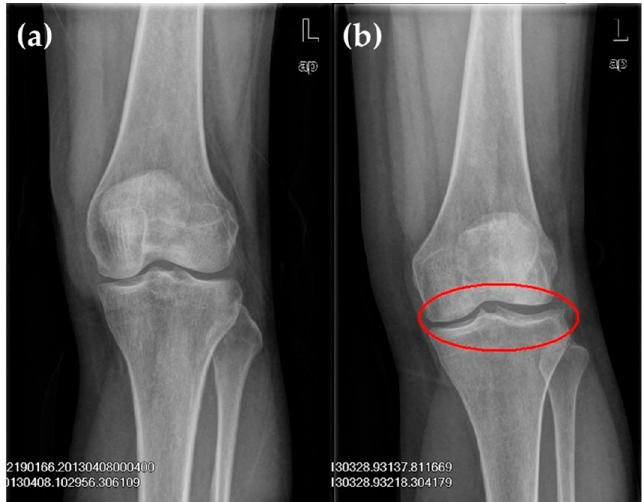
Figure 1. X-ray film of left knee joint: ( a ) The normal knee showed no obvious abnormal change in the sclerotin of bones in the joint, a well-proportioned joint gap and no obvious swelling of surrounding soft tissue; ( b ) The knee osteoarthritis (KOA) knee showed protruded left tibial condyles; labial hyperplasia in the external condyle of the tibia, margin of the lateral condyle of the femur and posterior margin of the patella; and a well-proportioned joint gap.